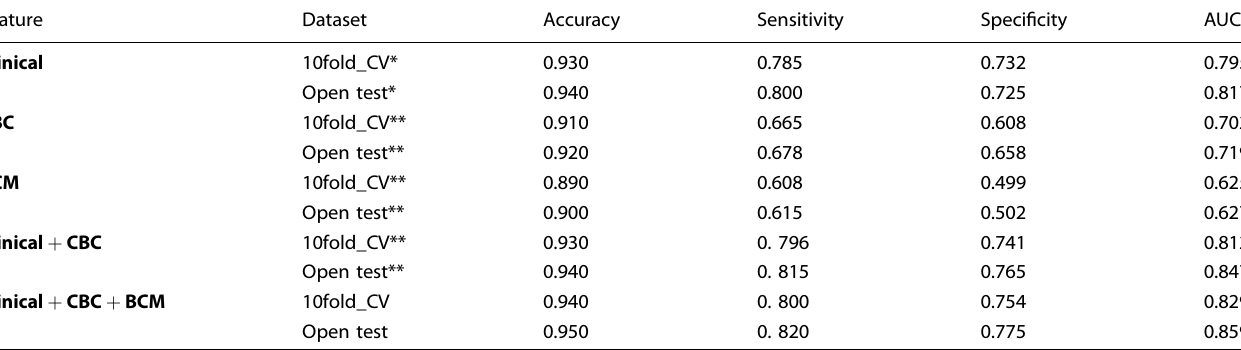
Table 4. Classi fi cation performance of XGBoost using clinical features, hematologic biomarkers and their combination, based on samples of disease duration ≤ 3